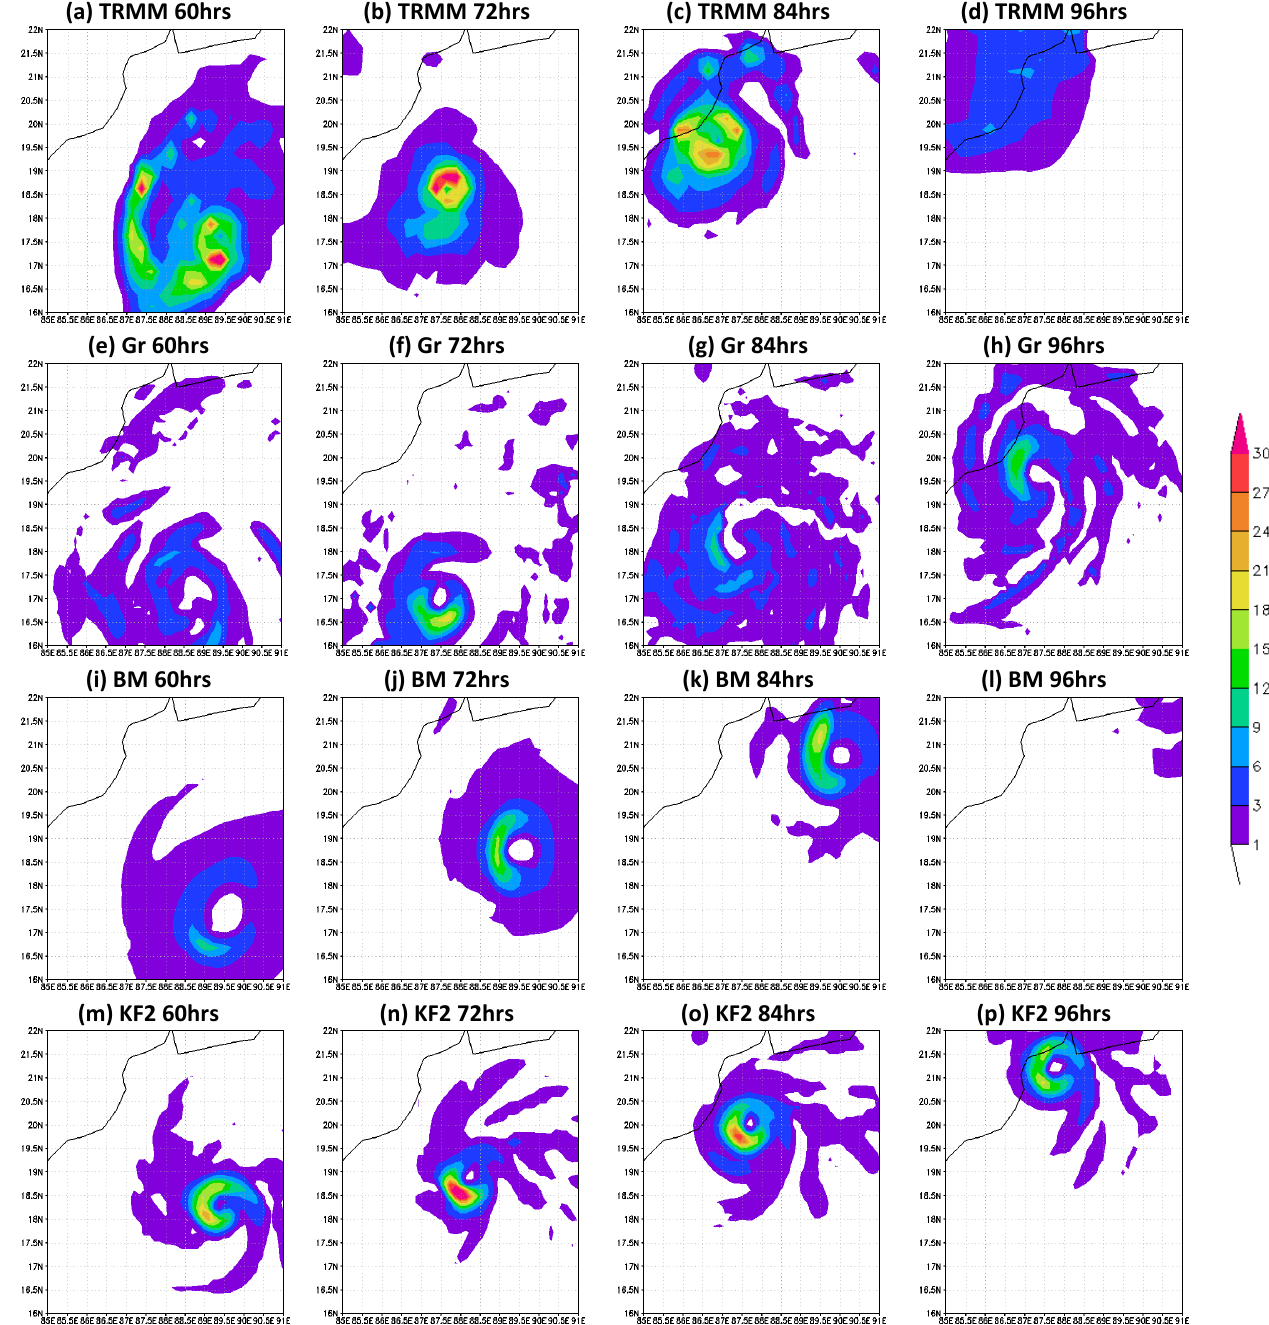
Fig. 5. Rain accumulated (mm) in 3h obtained from TRMM (a) – (d) data and as simulated by model with three CPS, namely Gr (e) – (h) , BM (i) – (l) and KF2 (m) – (p) during 60–96h of integration (that is from 00:00UTC, 28 to 12:00UTC, 29 October